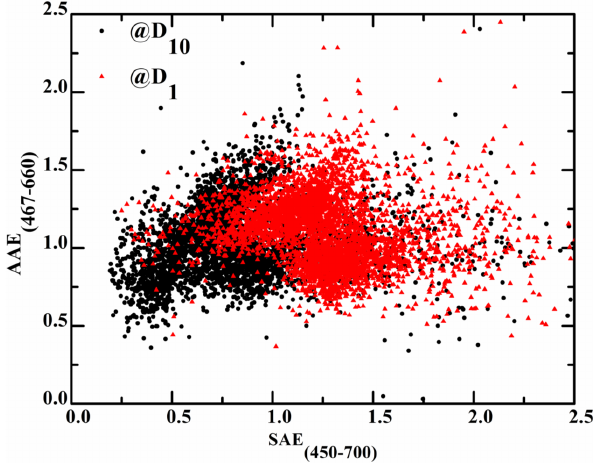
Figure 11. Correlation between scattering and absorption Ångström exponents (hourly averaged values) at Nainital for D 1µm and D 10µm particle-size